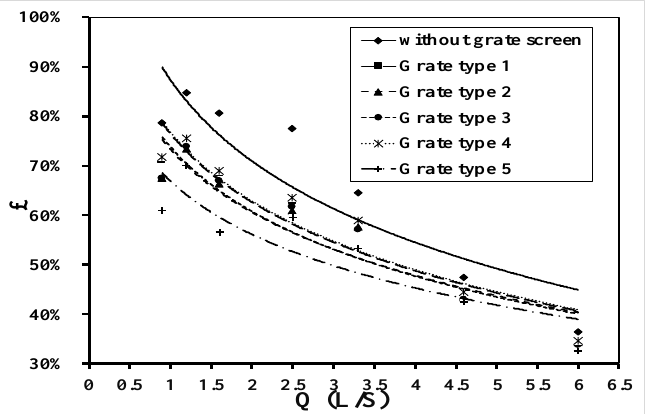
Figure 7. Relationship between discharge efficiency and passing discharge for different types of grate shapes.